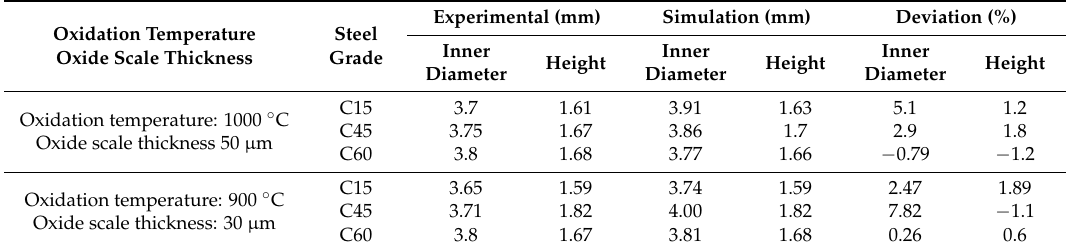
Table 4. Comparison between experimentally-measured and numerically-calculated height and inner diameter after ring compression tests at 1000 ◦ C and 900 ◦